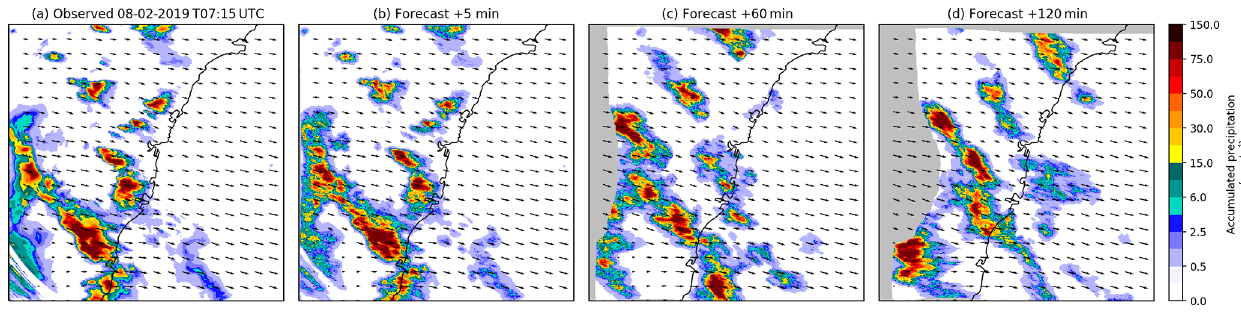
Figure 21. Comparison of a member of 5min rainfall ensemble for (b) + 30min, (c) + 60min and (d) + 120min nowcasts initialized with (a) radar-based rainfall analysis from the Australian radar network valid at 07:15UTC on 8 February 2019 on a 512 × 512 pixel grid (256 × 256km) (event no. 1 in Table